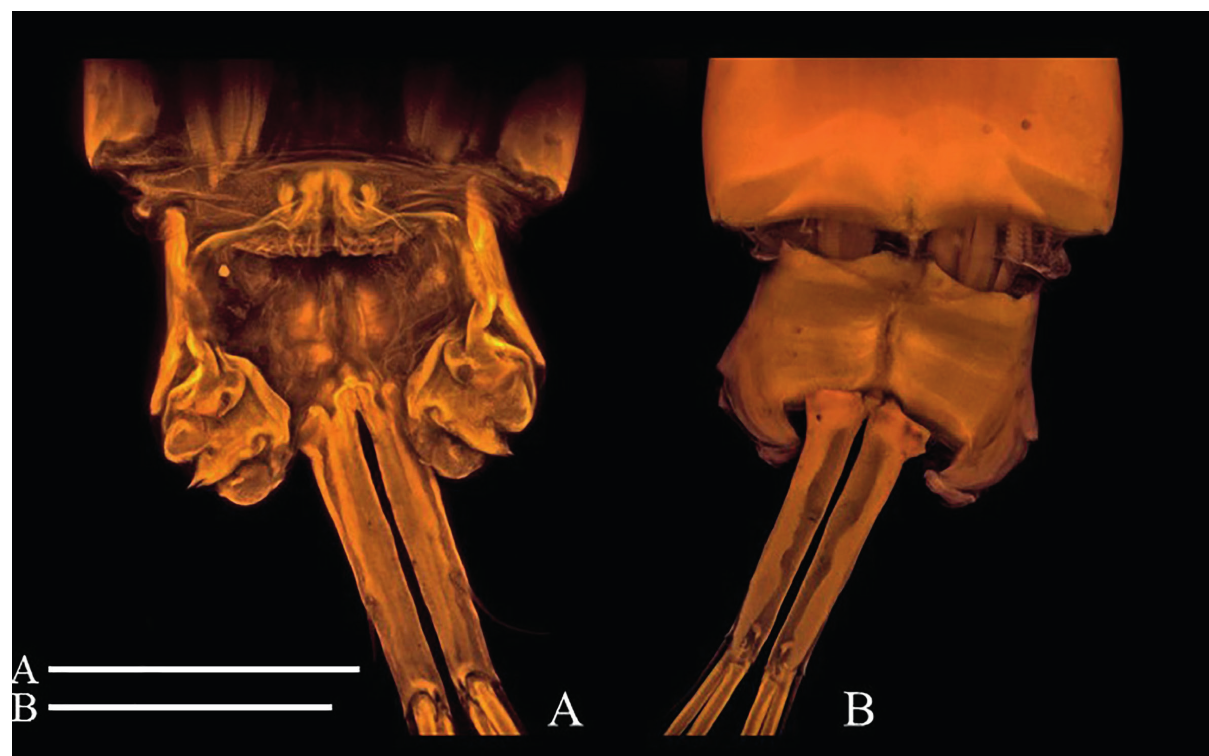
Figure 9. Clausidium persiaensis sp. nov. (female). Confocal laser scanning microscopy images. A, caudal rami and anal somite, dorsal; B, caudal rami and anal somite, ventral. Scale bars: 100